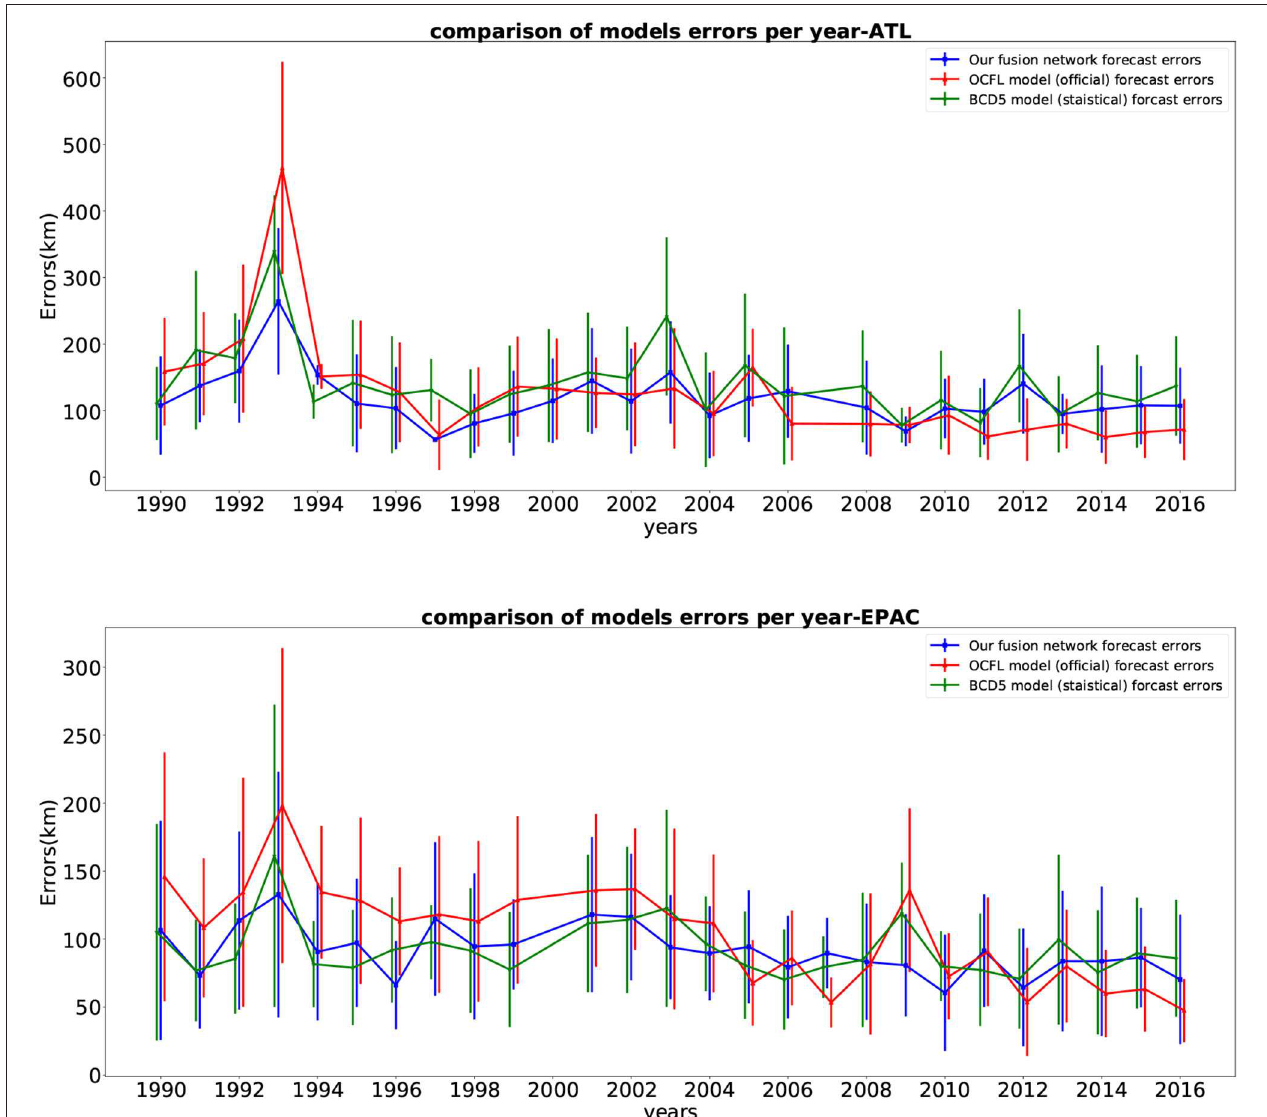
FIGURE 6 | Yearly average of 24-h storm track forecasting errors (km) and standard deviation on the test set (top figure for storms in Atlantic, bottom figure for storms in East Pacific) for our fused network forecasts (blue), the CLP5 model forecasts (green) and the official NHC forecasts (red),